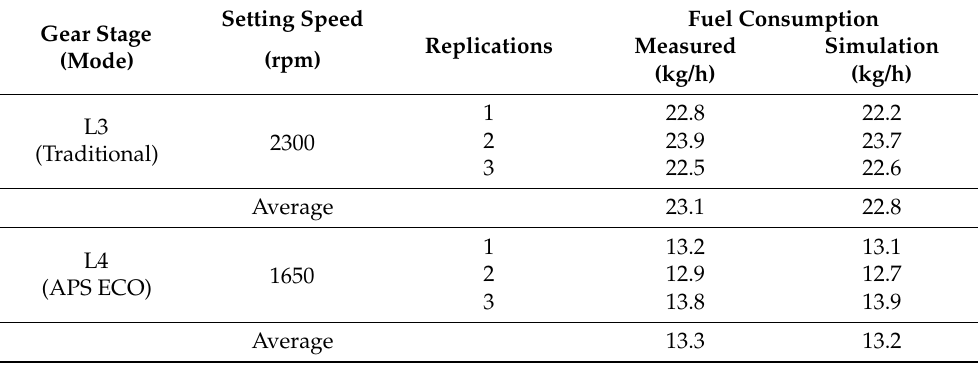
Table 7. Fuel consumption analysis during rotary